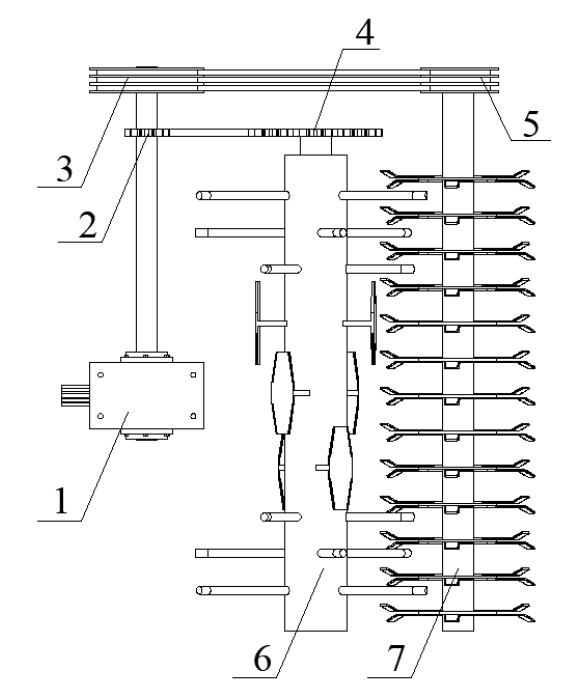
Table 1. Main technical parameters of double-roller